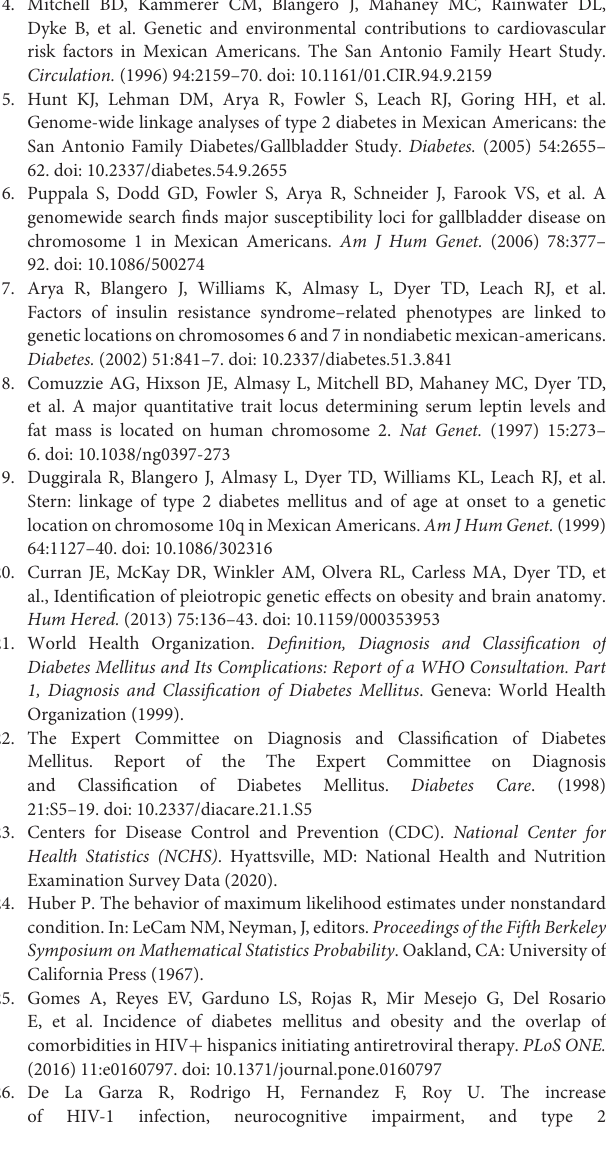
Supplementary Table 1 | General description and stratification by sex of selected variables from the SAMAFS ¶ . Supplementary Table 2 | General description and contrast by sex of selected variables from HHANES ¶ 2018